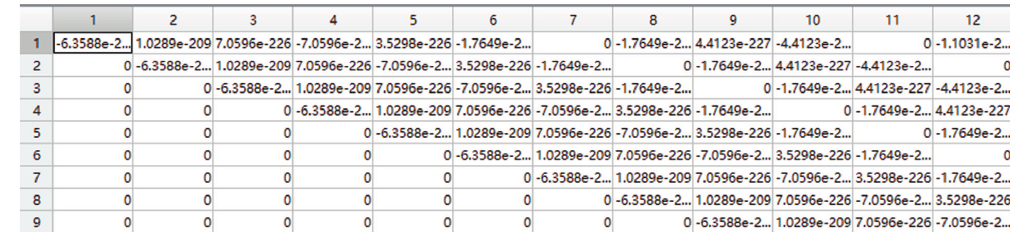
Figure 4: The result of Corollary Table 1: Running time comparison of Lemma 4 and Corollary 1.